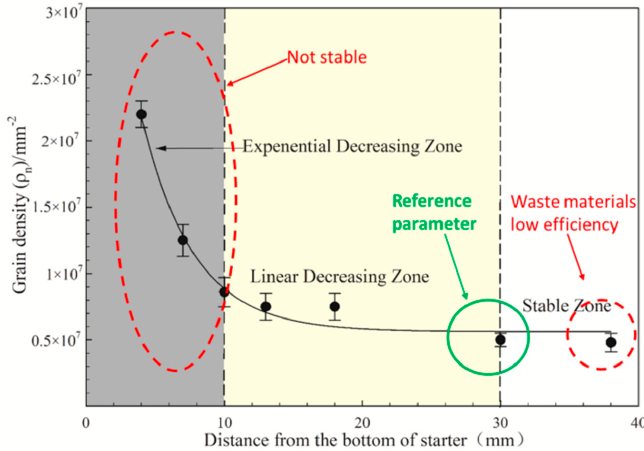
Figure 6. Grain density and average deviations between the <001> direction of grains and the direction of the heat flux as a function of distance from the bottom of the starter block.